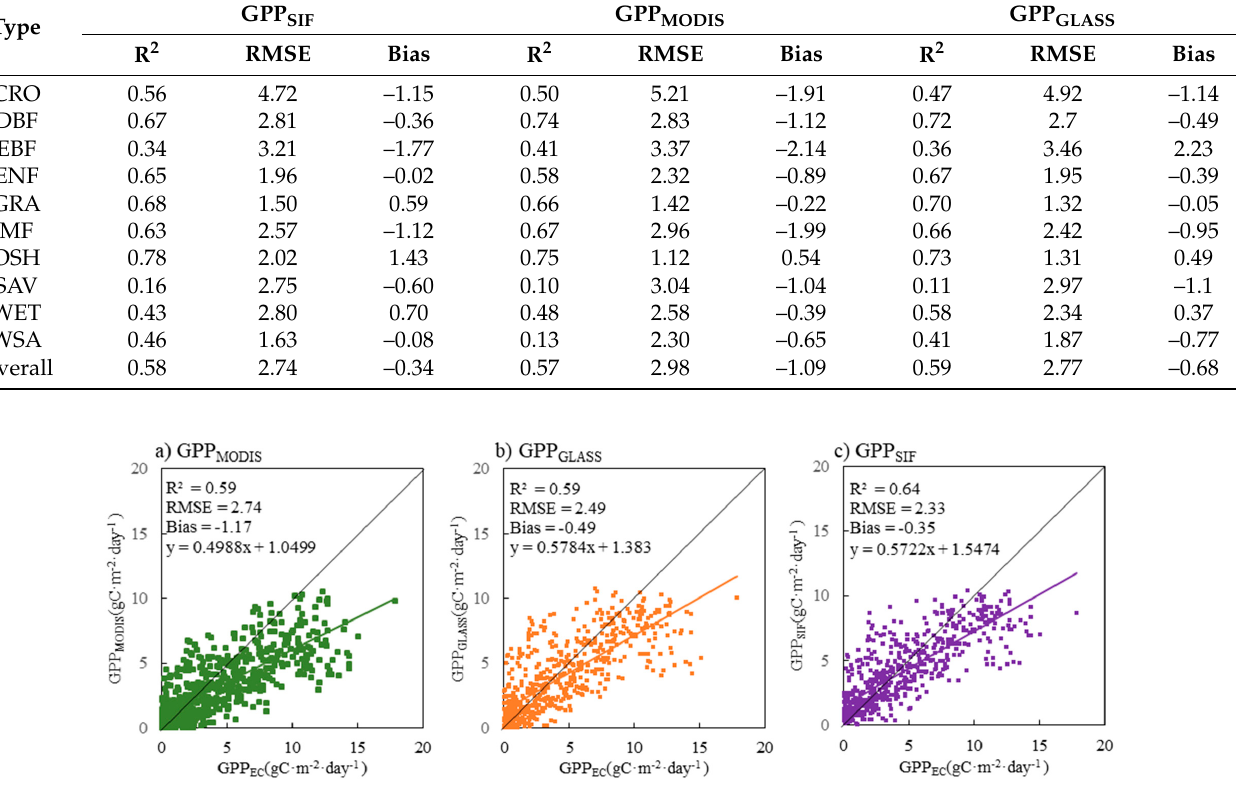
Figure 2. Evaluation of GPP MOD , GPP GLASS and GPP SIF against FLUXNET GPP in 2014.